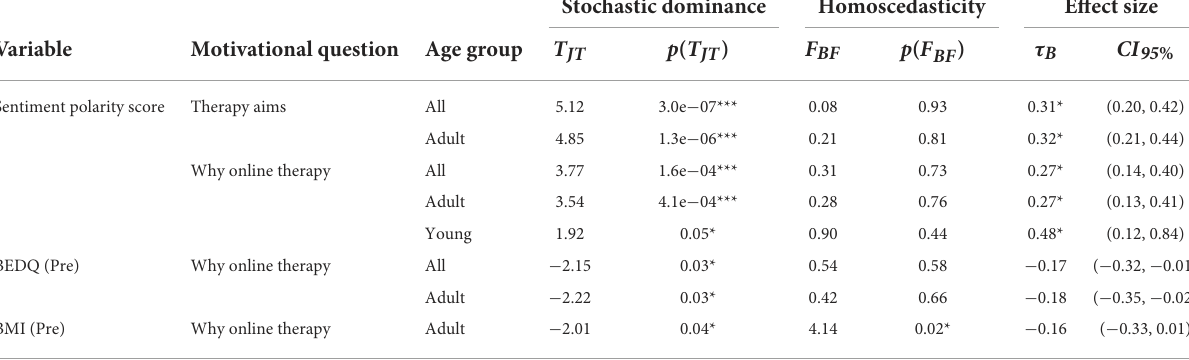
TABLE 6 Statistical interaction between motivational type and patient variables, by motivational question and age group.